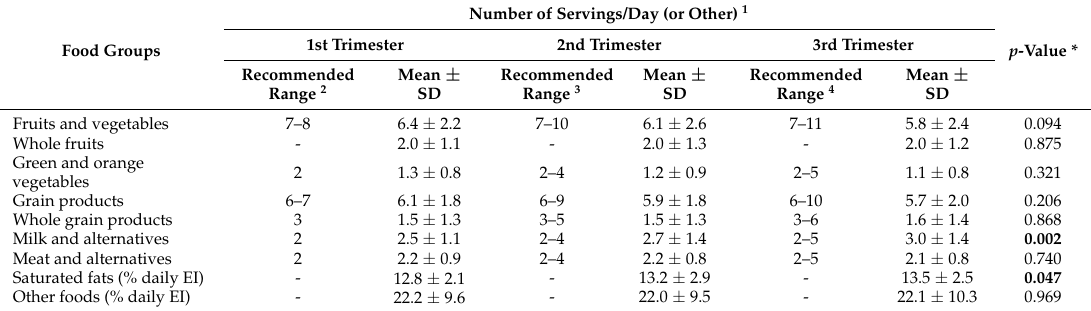
Table 2. Servings of 2007 Canada’s Food Guide food groups and subgroups throughout pregnancy.